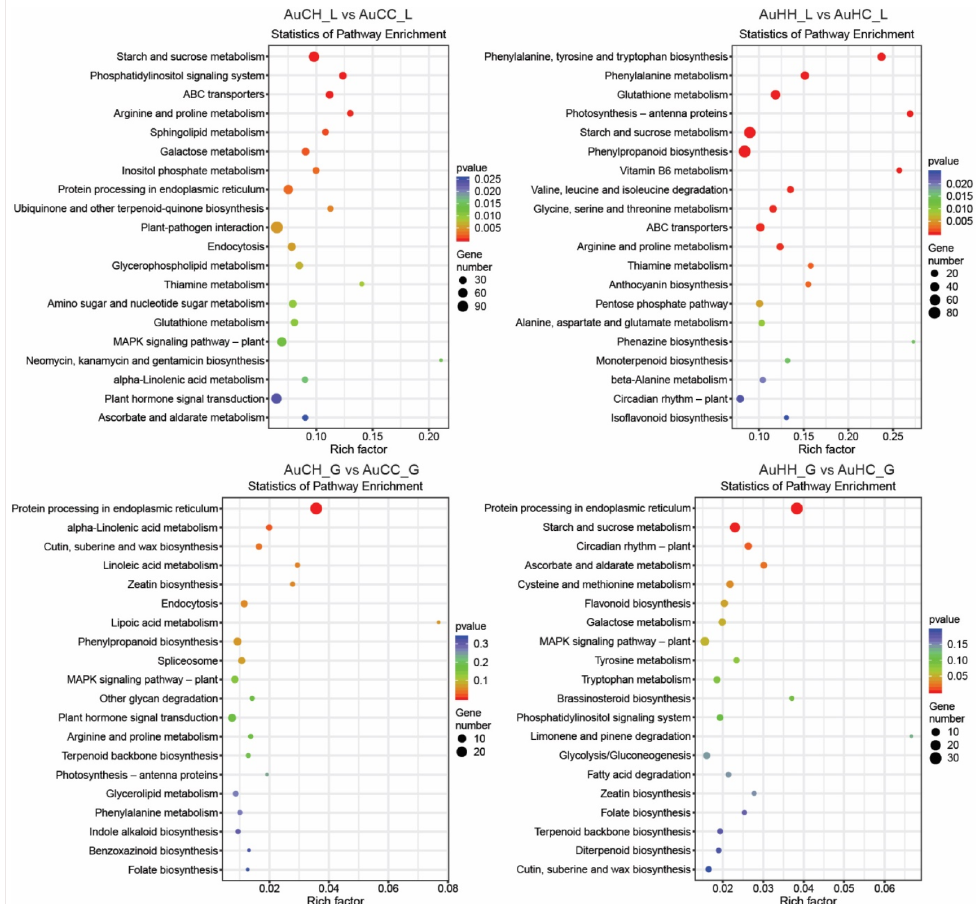
Figure 4. Scatter plots showing the top enriched KEGG pathways associated with progeny heat stress-responsive genes in different pair-wise comparisons. The treatment groups are: AuCC (DBA Aurora progeny treated with the control, originated from control group parents), AuCH (DBA Aurora progeny treated with heat stress, originated from control group parents), AuHC (DBA Aurora progeny treated with the control, originated from heat stress group parents), AuHH (DBA Aurora progeny treated with heat stress, originated from heat stress group parents). _L indicates flag leaf library and _G indicates developing grains library. The size of the dots is representative of the number of genes enriched under each KEGG pathway. The rich factor indicates the degree of enrichment, which was calculated based on the ratio of heat stress-responsive genes:all genes that can be annotated to a specific KEGG